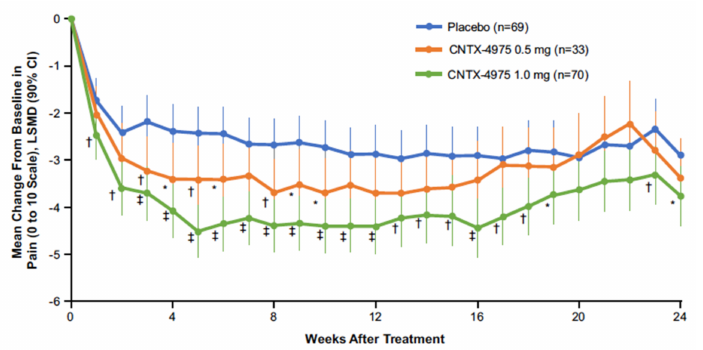
Figure 2. (Reprinted with permission from [39]) Plot of the change from baseline in average weekly WOMAC pain with walking scores through week 24 in patients treated with intra-articular capsaicin (CNTX-4975, specifically) versus placebo is shown. A mixed model for repeated measures was used in the modified intent-to-treat population. Week 12 was the prespecified landmark endpoint. Baseline scores (range 0–10): placebo 7.4, CNTX-4975 0.5 mg 7.2, CNTX-4975 1.0 mg 7.2. * = P < 0.1; † = P < 0.05; ‡ = P < 0.001 versus